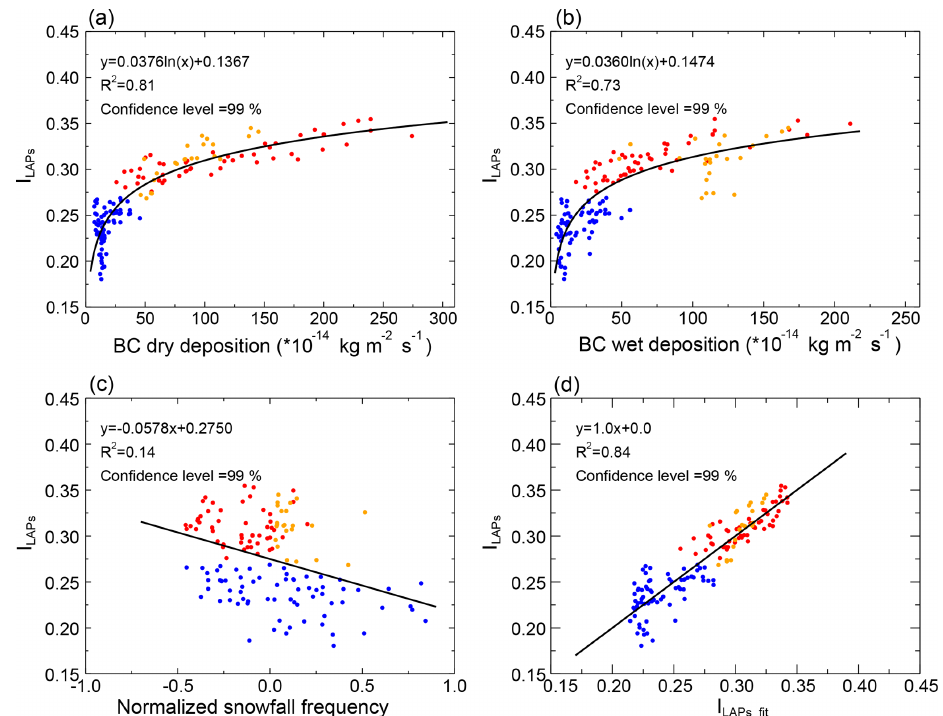
Figure 9. Scatterplots of I LAPs versus (a) BC dry deposition, (b) BC wet deposition, (c) normalized snowfall frequency, and (d) fitted I LAPs ( I LAPs_fit ), which is fitted with BC dry and wet deposition and snowfall frequency using multiple linear regression. BC deposition data are from the MERRA-2 reanalysis, and snowfall data are from the ERA-Interim reanalysis in January–February from 2003 to